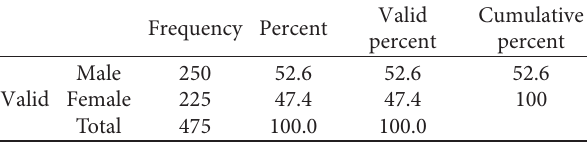
Table 1: Gender of the respondents.